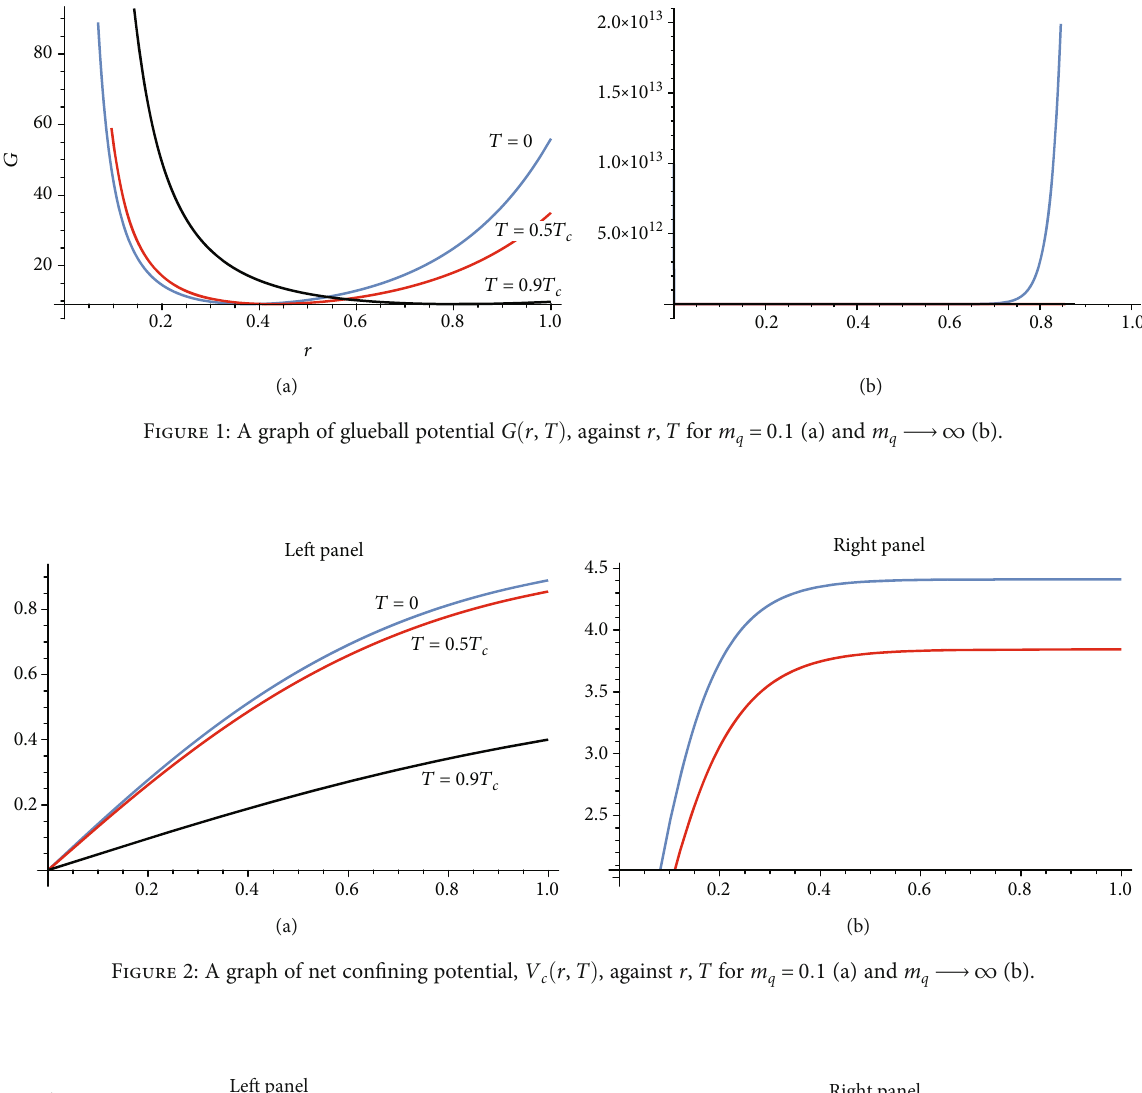
ð r , T Þ , against r , T for m c